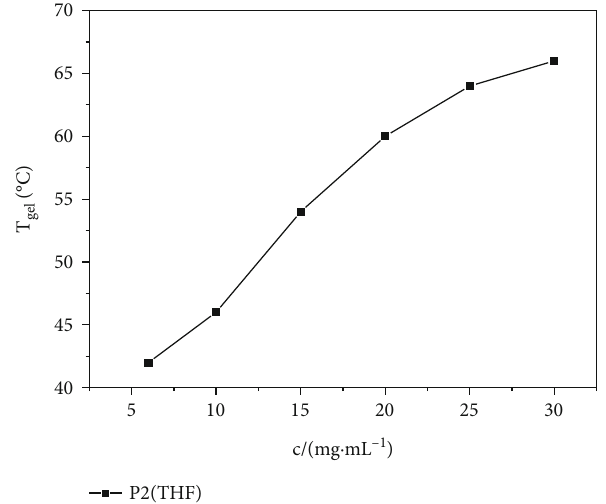
Figure 15: P2 (THF) gel-sol phase transition temperature